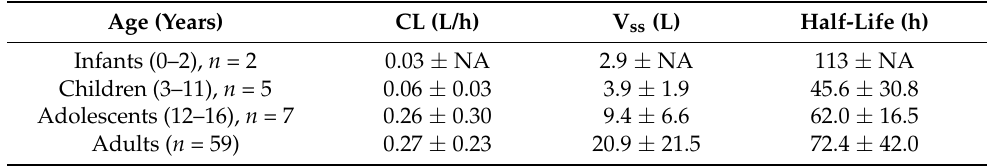
Table 3. PK parameters (mean ± sd) of Gemtuzumab Ozogamicin in children following 9 mg/m 2 in period 1 as a function of